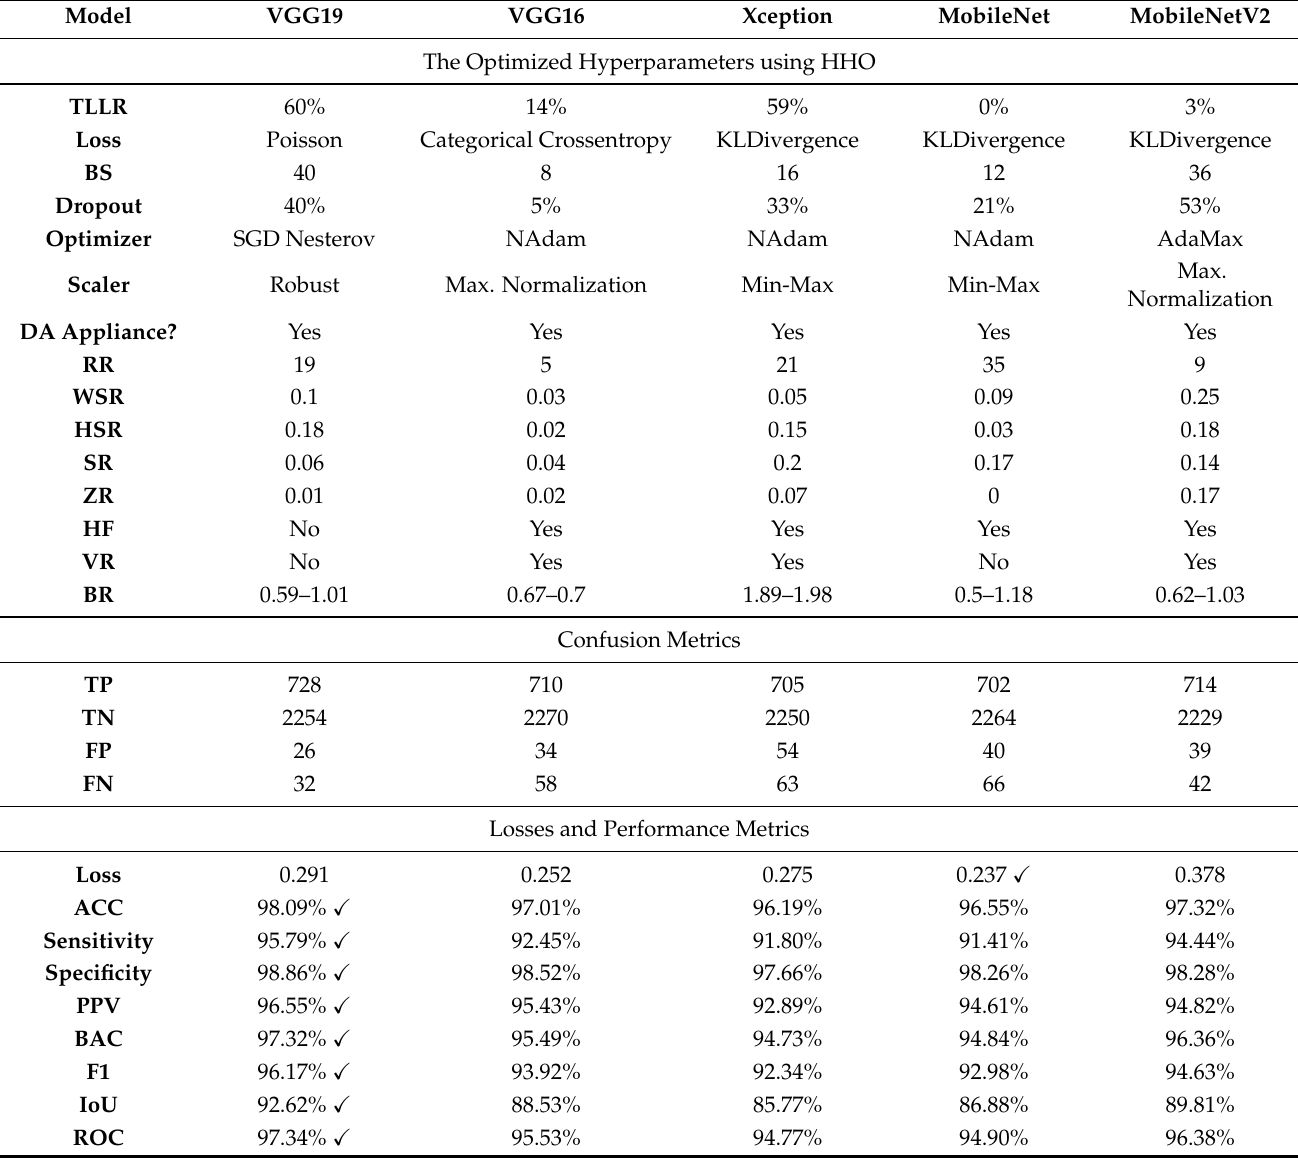
Table 4. The reported results concerning the “Monkeypox Skin Images Dataset” (MSID) after fine- tuning and hyperparameter optimization using